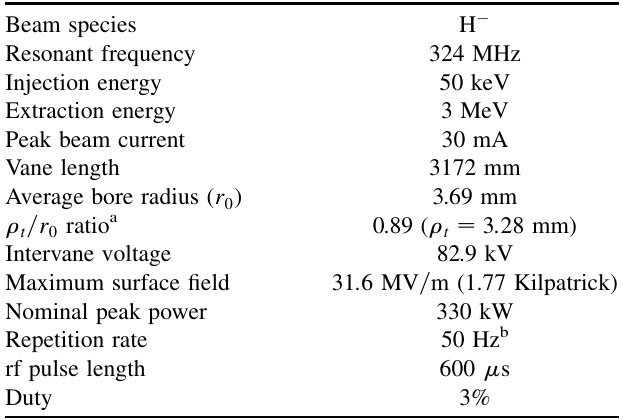
TABLE I. Design parameters of J-PARC RFQ